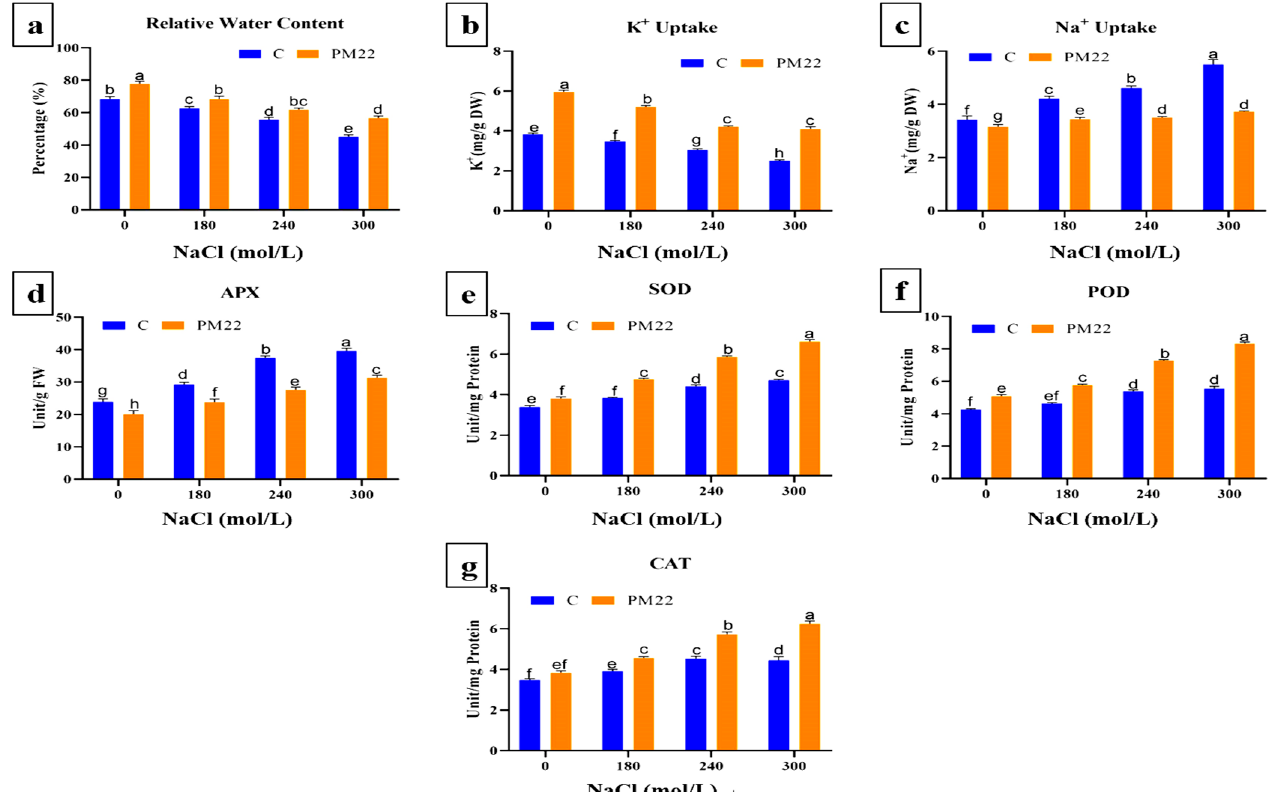
Figure 3. Impacts of various treatments on relative water content, ion homeostasis, and antioxidant activities of PM22-inoculated maize at different salt stress levels (0, 180, 240, and 300 mM). Soil containing non-inoculated seeds and soil with seeds inoculated with B. Safensis (PM22) were the two treatments. The values are the averages of three triplicates with standard errors of the mean. Different alphabets have significantly different values ( p = 0.05) from each other, according to Tukey’s least significant difference test.